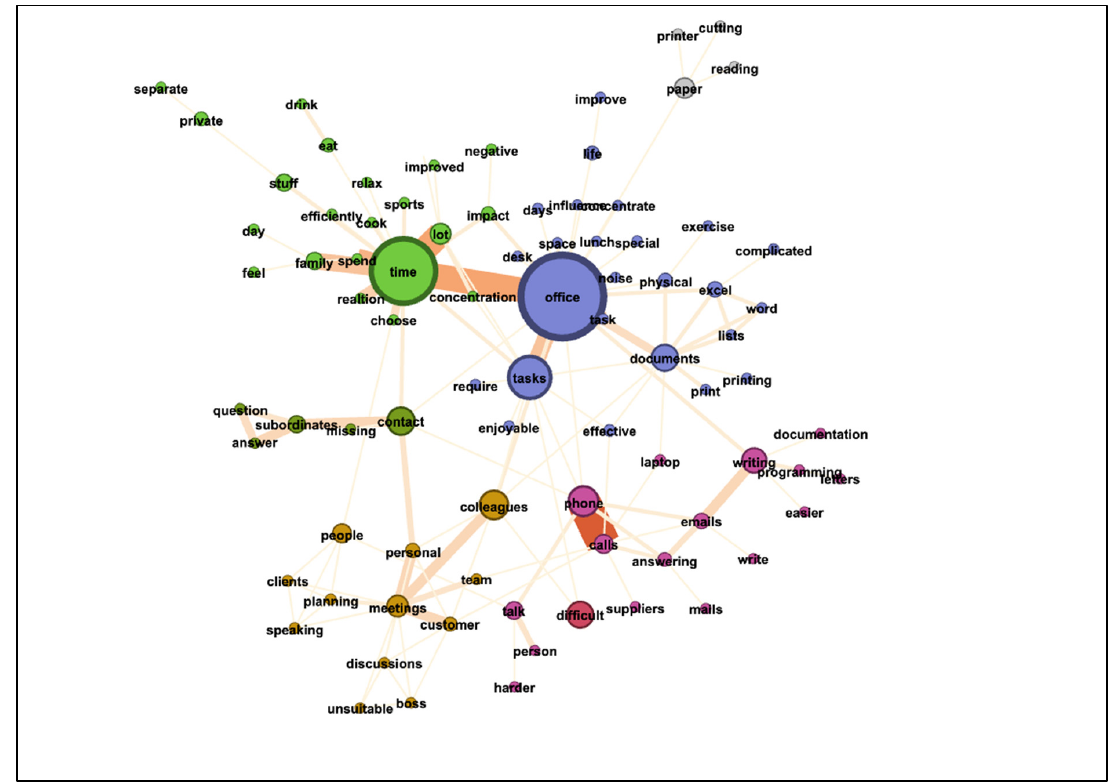
Figure 1. Switzerland Semantic Network.